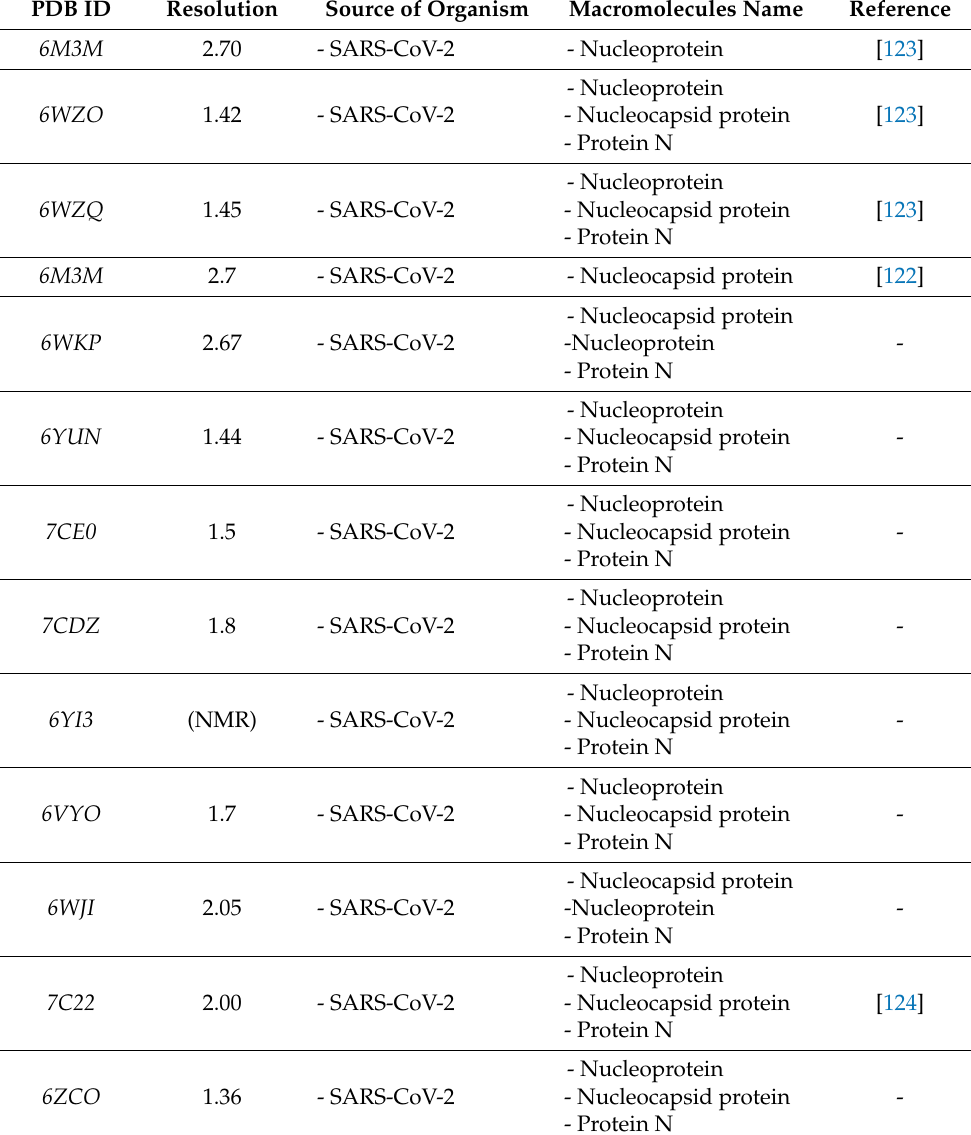
Table 5. The known 3D structures of nucleocapsid available on protein data bank (PDB). PDB